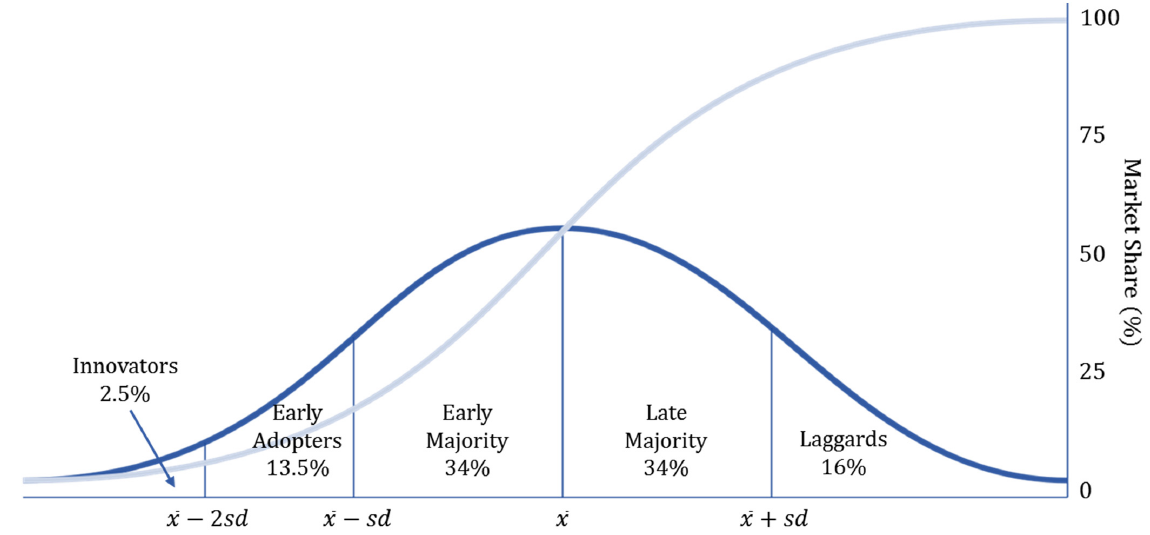
Figure 1. Diffusion of innovations by innovator groups and market share (own figure based on Rogers, 2003 [13]).